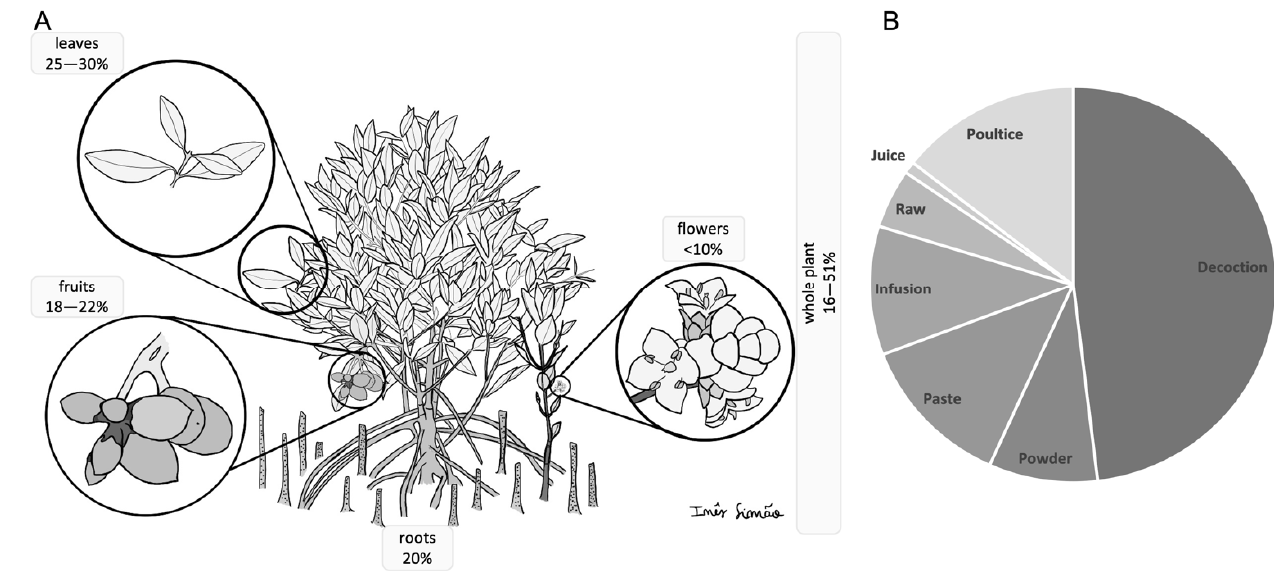
Figure 1. Most widely used parts of the plants ( A ) and most common preparations ( B ) in traditional medicine. Avicennia marina was illustrated by Inês Simão .